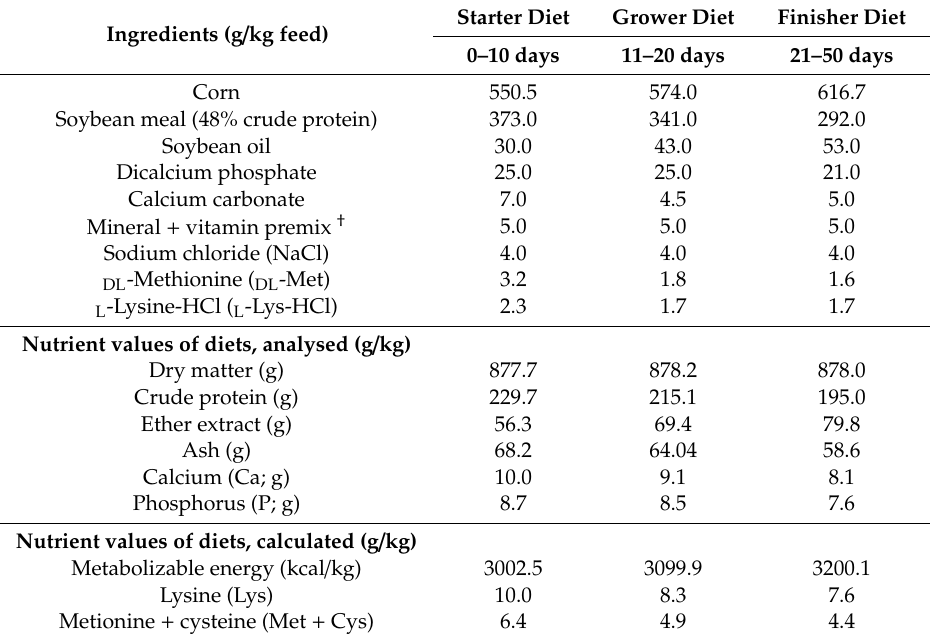
Table 1. Feed ingredients and nutrient composition of basal diets (as-fed